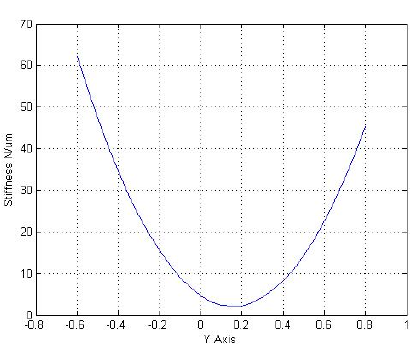
Figure 23: Cartesian stiffness in the Y-direction as function of the Z-coordinate at fixed Y=0.0 and X=1.0.